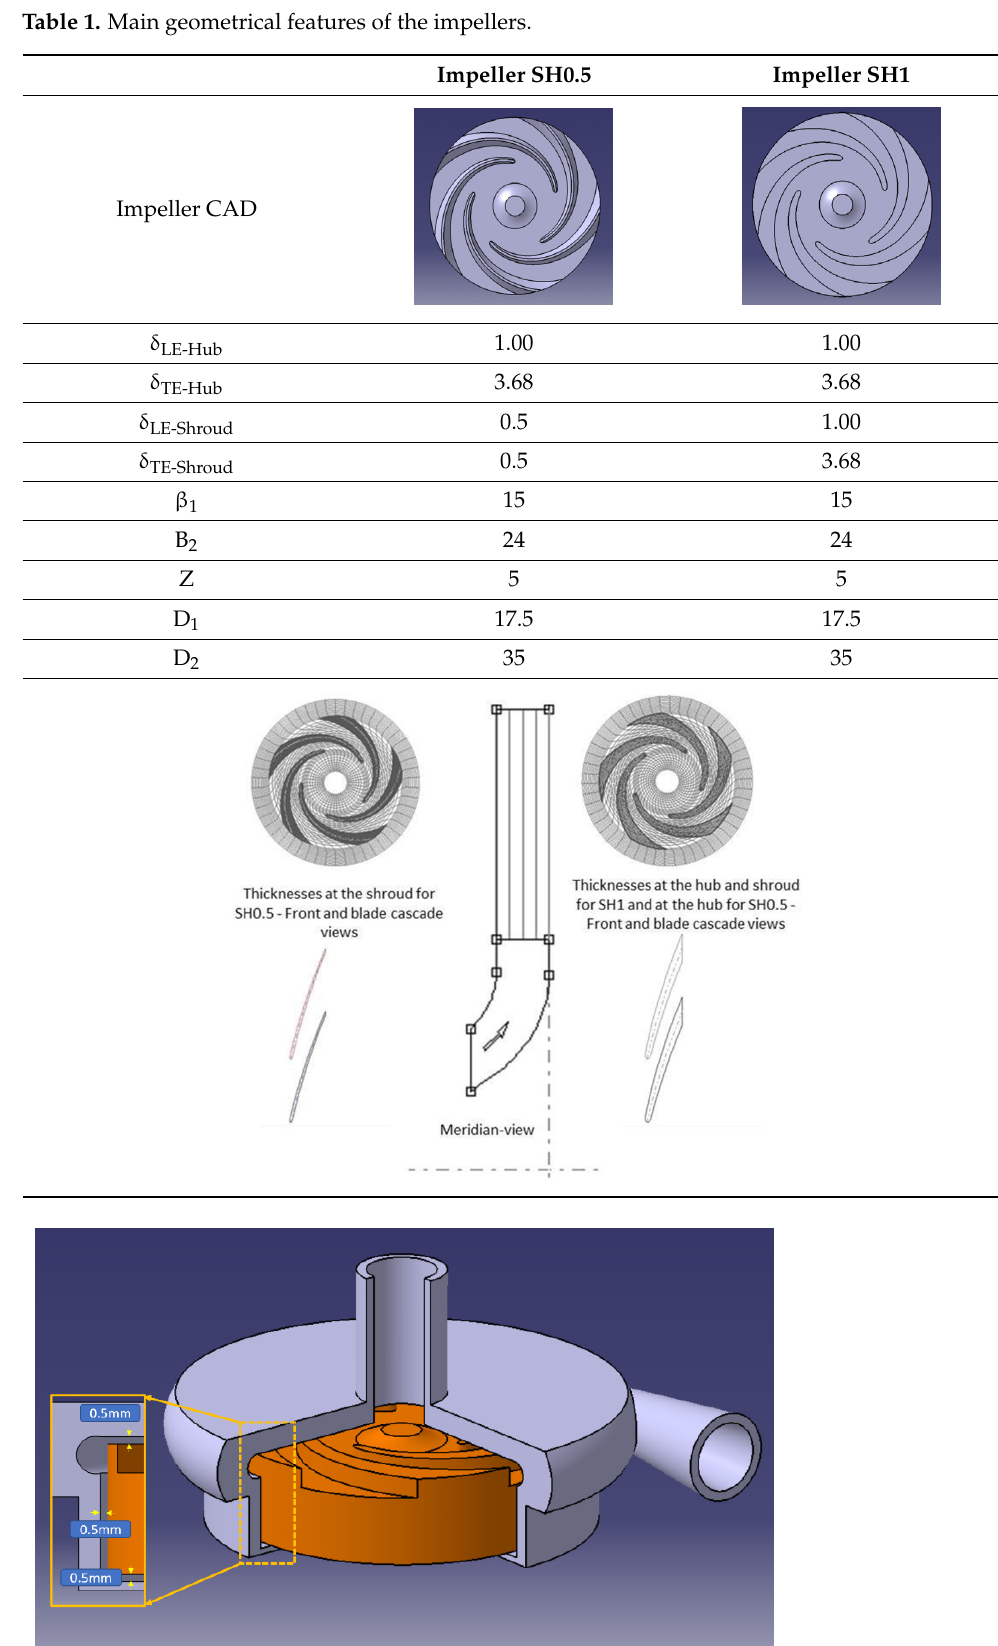
Figure 2. General schema of the pump with the dimensions.